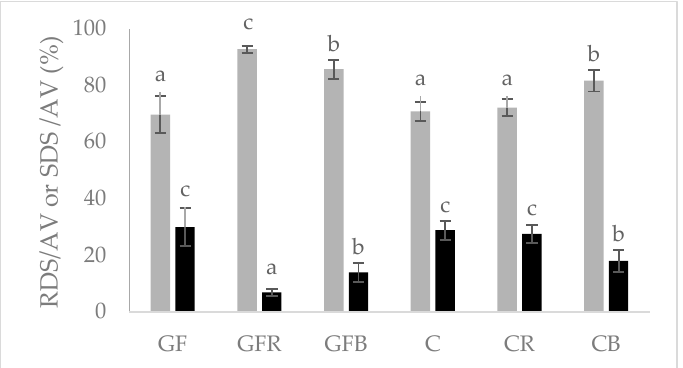
Figure 2. Rapidly (grey bar) and slowly (black bar) digestible starch fractions in cooked gnocchi. RDS, rapidly digestible starch; SDS slowly digestible starch; AV, total available starch. For each parameter, bars with different letters are significantly different ( p < 0.05).